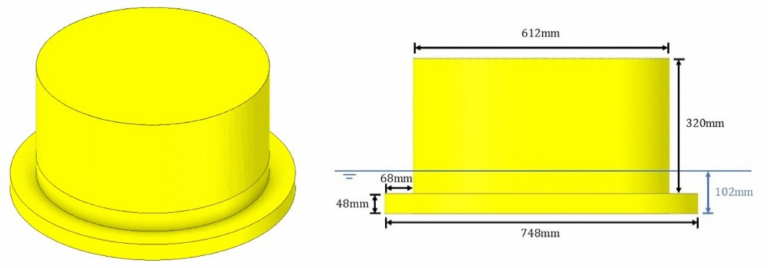
Figure 2. Reduced scale model dimensions.